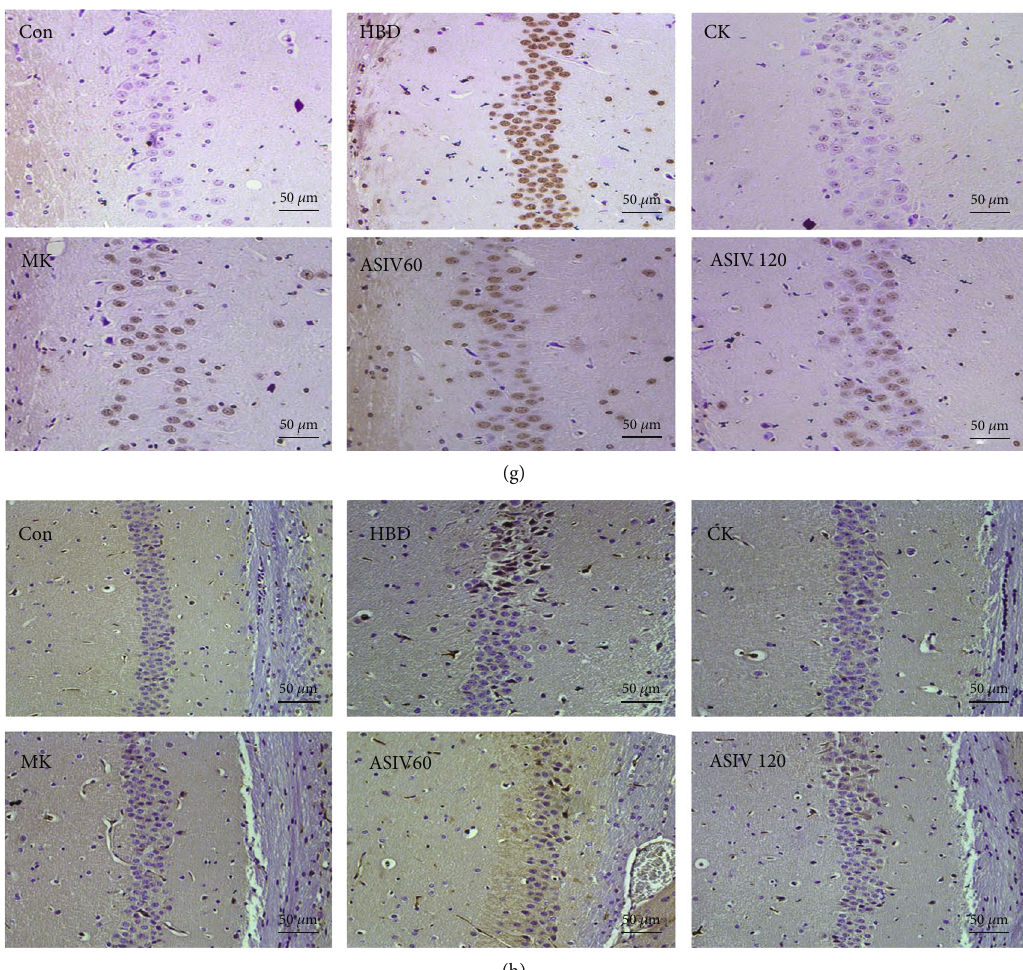
Figure 4: AS-IV and calpain-1 knockout reduced the apoptosis of hippocampal neurons in mice with hypoxic brain injury. (a – d) Caspase-3, Bax, and Bcl-2 protein expression levels were observed by Western blotting ( n = 3 ; Caspase-3, F ð 5,12 Þ = 200 : 389 ; Bax, F ð 5,12 Þ = 117 : 226 ; Bcl-2, F = 75 : 166 ). (e, g) TUNEL staining was used to observe the number and percentage of TUNEL-positive cells in the hippocampal CA1 ð 5,12 Þ area of mice in each group ( n = 3 ; F ð 5,12 Þ = 373 : 068 ). (f, h) Immunohistochemistry was used to observe caspase-3 protein expression in the CA1 region of the mouse hippocampus ( n = 3 ; F ð 5,12 Þ = 124 : 563 ). Data are presented as the mean ± SD . ∗∗ P < 0 : 01 compared with the HBD group, # P < 0 : 05 , ## P < 0 : 01 compared with the ASIV 60mg/kg